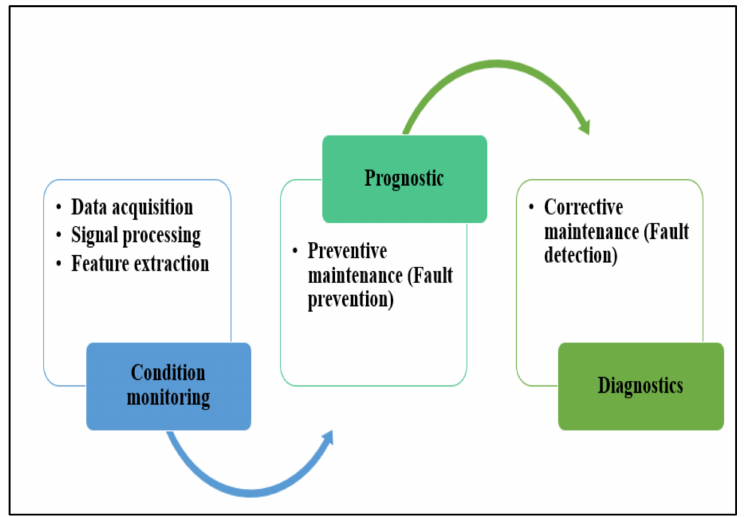
Figure 3. An overview of condition-based maintenance.